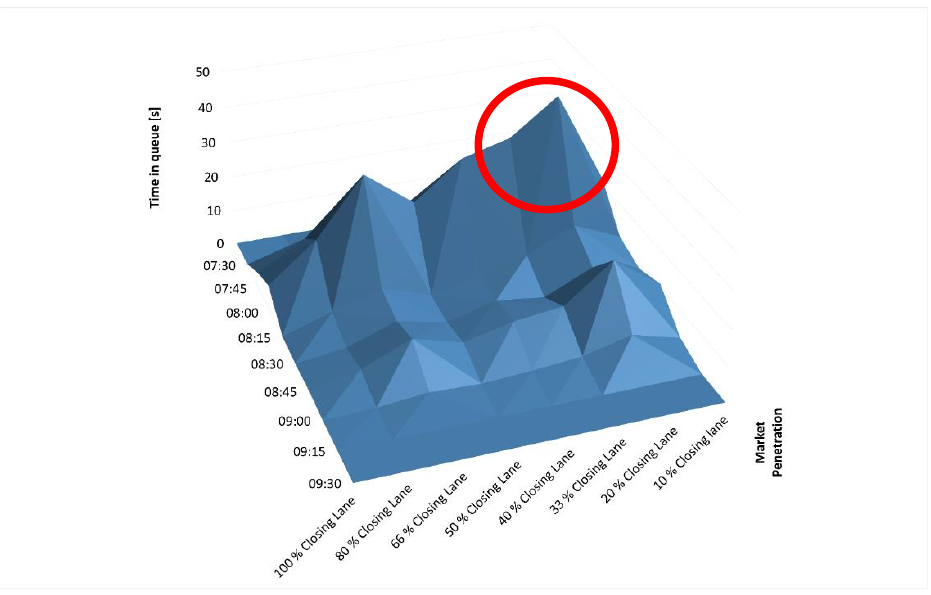
Figure 10. Time in queue on the closing lane .